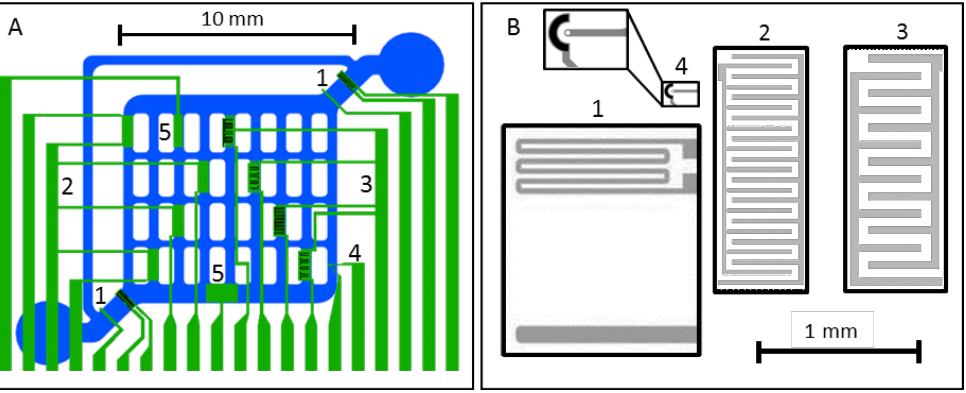
Figure 3. Scheme of the fluidic channels (blue) and location of the Pt-sensor structures (green) on the glass chip: ( A ) ETµP (1), eight common connectors for IDES with 30-µm (2; four connectors from left) and 50-µm (3; four connectors from right) finger widths, one oxygen (4) and two pH sensors with different sensor areas (5); ( B ) to-scale comparison of IDES (2, 3), directly heated ETµPs (1) and oxygen-electrode structures (4, top left: zoom of structure). The pumping force of the ETµP (1) is generated in the volume confined by the field electrode (lower horizontal stripe) and the common ground for the field electrode and the heating element (lower connector of the meander). Active surfaces of the oxygen sensor are marked in white (working electrode) and black (counter-electrode); finger widths and spacings were equal in each of the two IDES types. The outer boxes (30-µm structures: